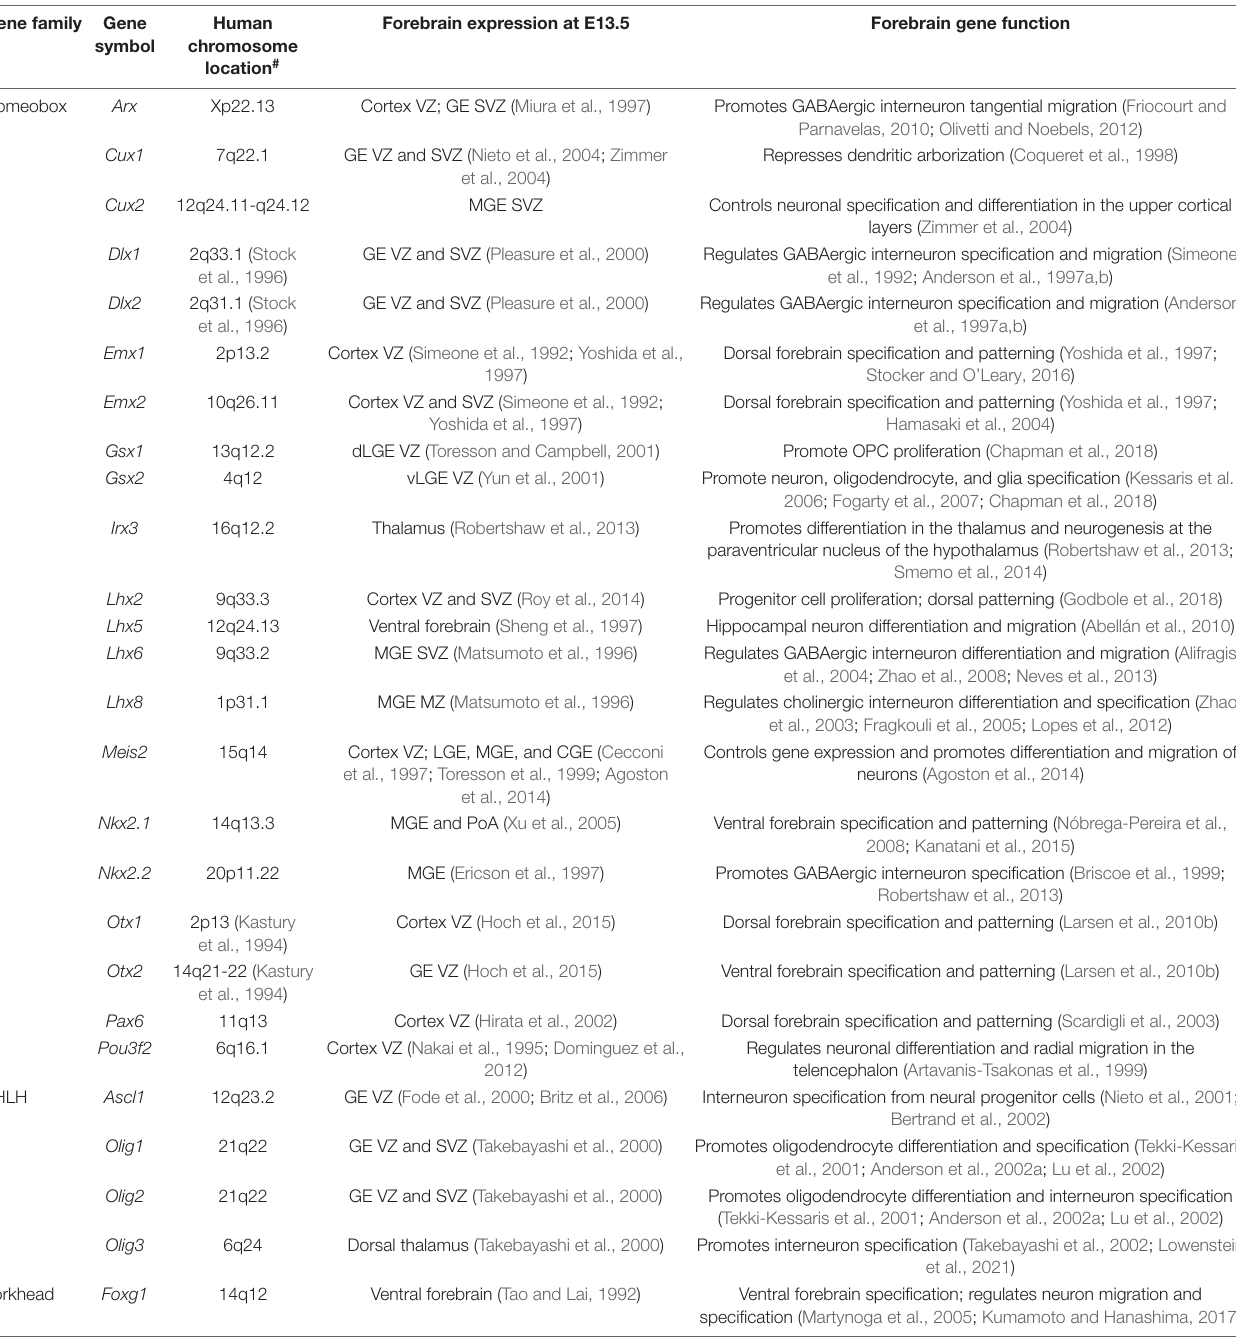
TABLE 1 | Summary of selected transcription factors required for forebrain